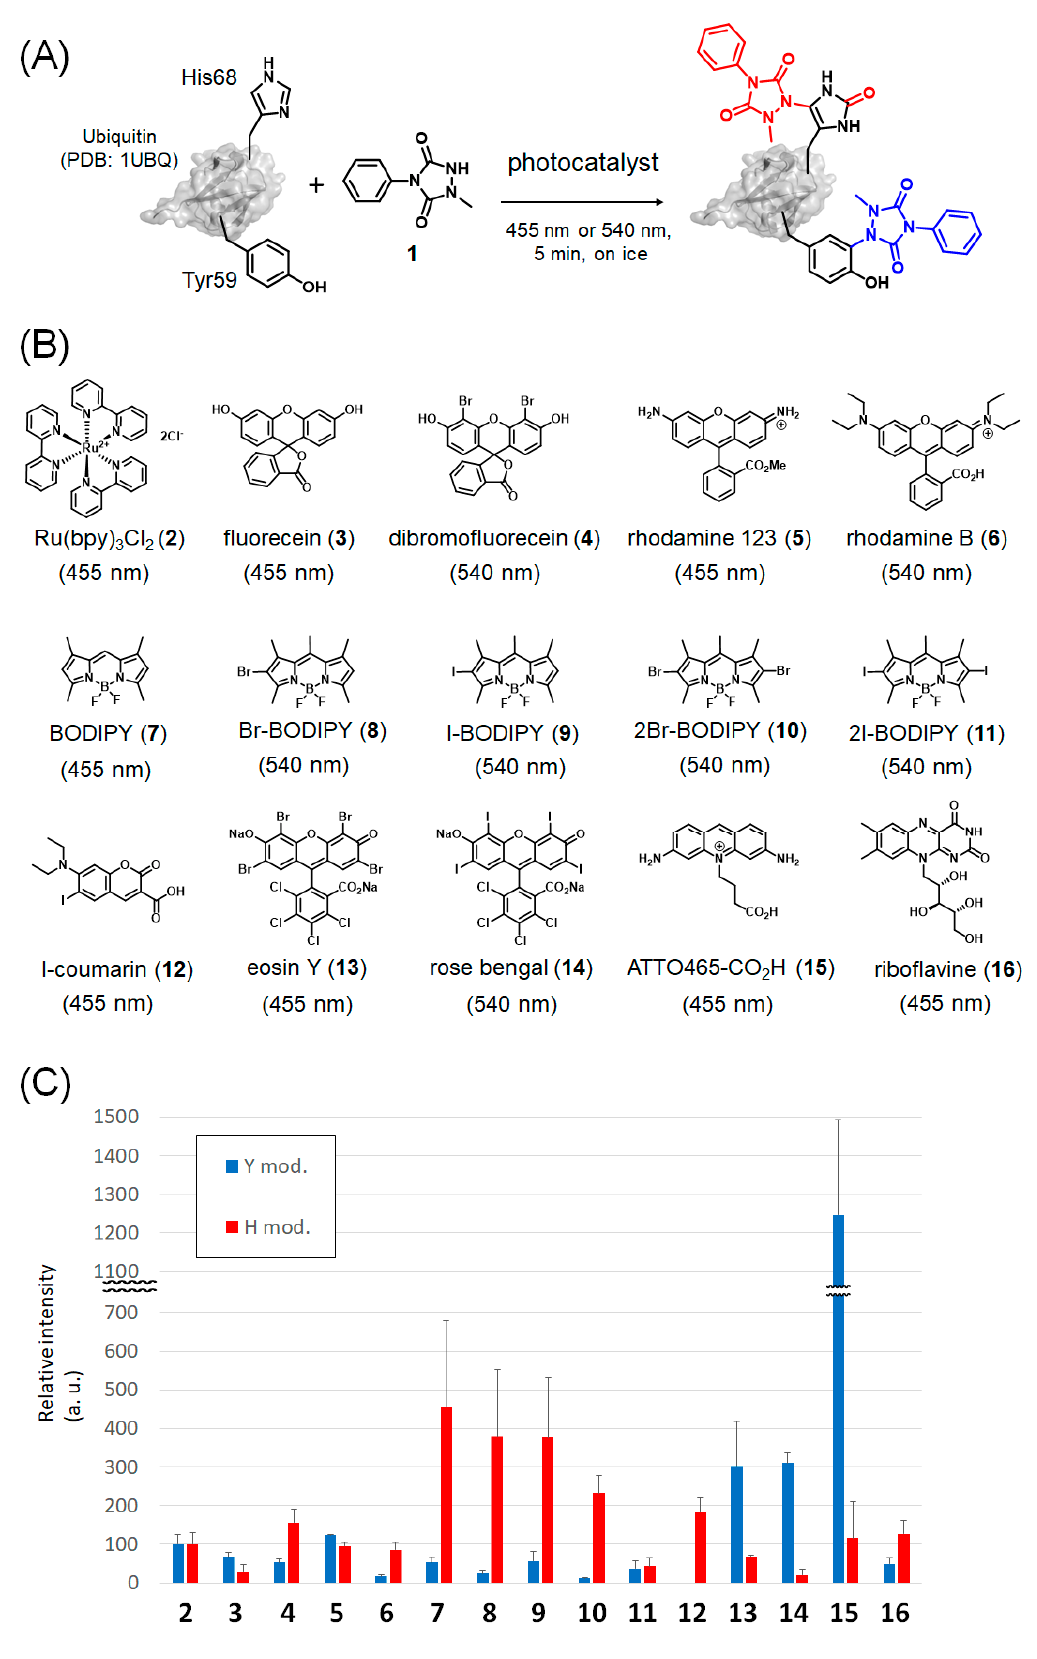
Figure 2. Screening of photocatalysts. ( A ) Scheme of ubiquitin labeling. ( B ) Chemical structures of photocatalyst candidates. ( C ) Relative MS1 intensity of labeled peptide fragments.